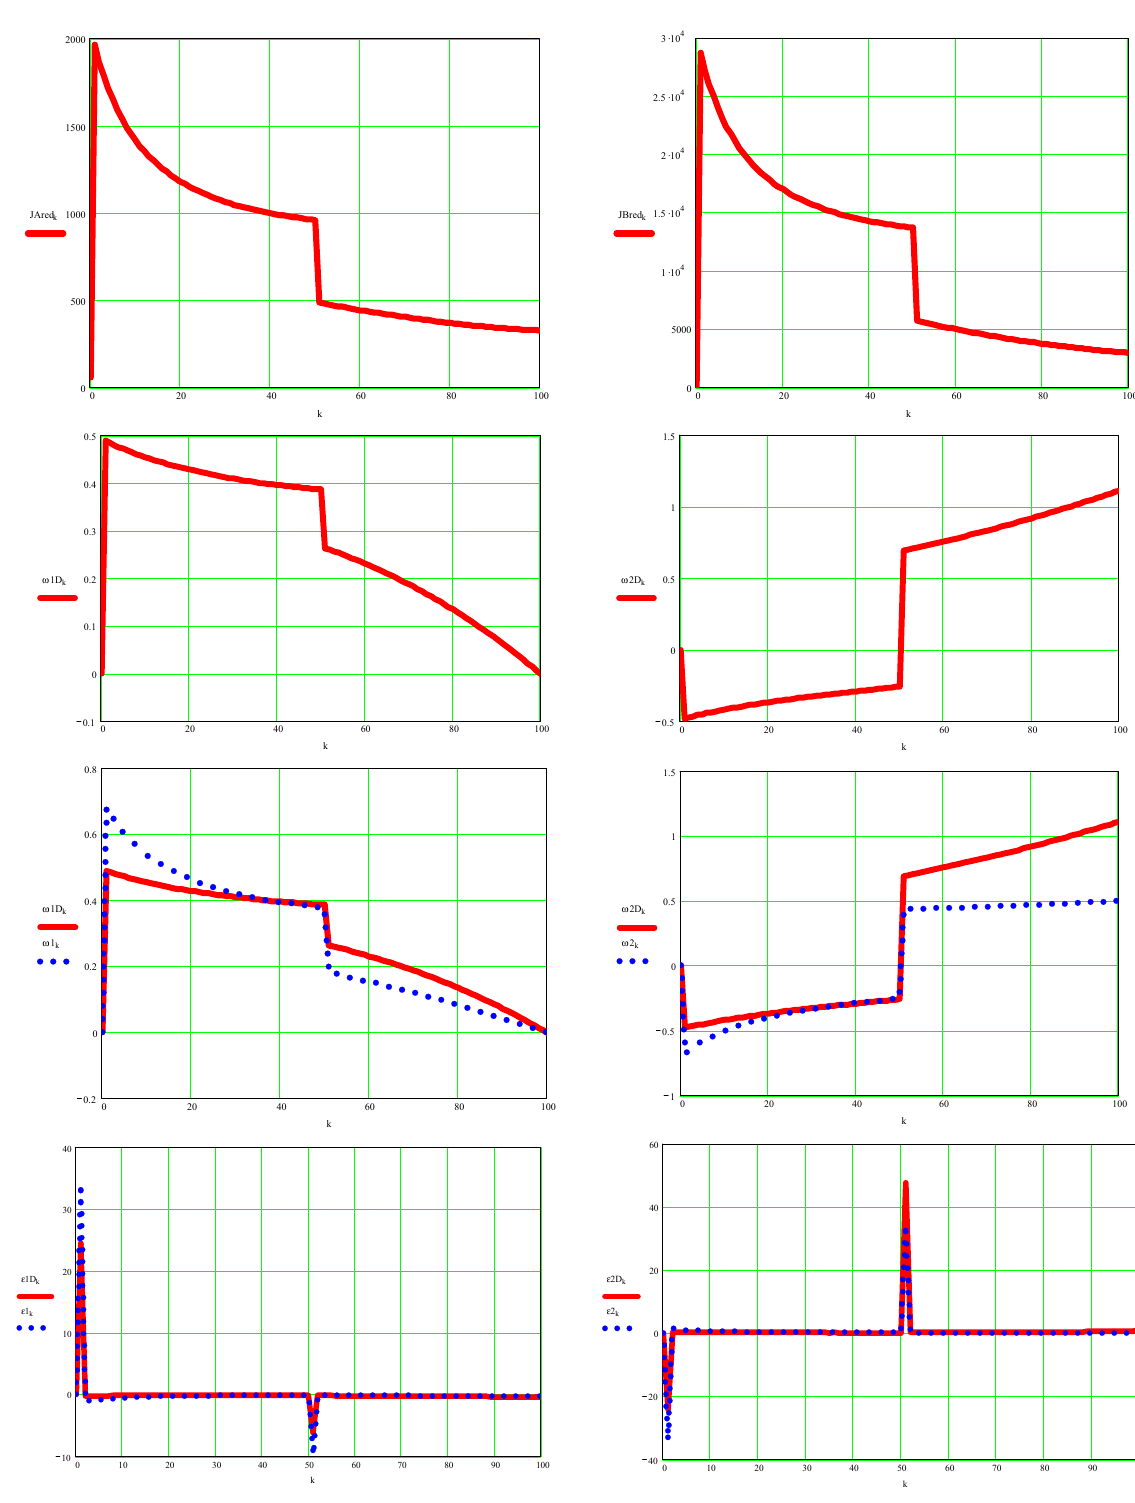
Figure A10. In the figure you can see above the moment of reduced mass inertia in the coupling A element 1 (left) and in the coupling B element 2 ( right ), then immediately below are represented the real, dynamic angular velocity of the element 1 (on the left ) and of the element 2 ( right ), immediately below you can see the comparative graphs between the dynamic and kinematic angular velocity for element 1 ( left ) and element 2 ( right ), and below you can finally see the comparative graphs of the dynamic angular accelerations and kinematics for element 1 ( left ) and for element 2 ( right ).